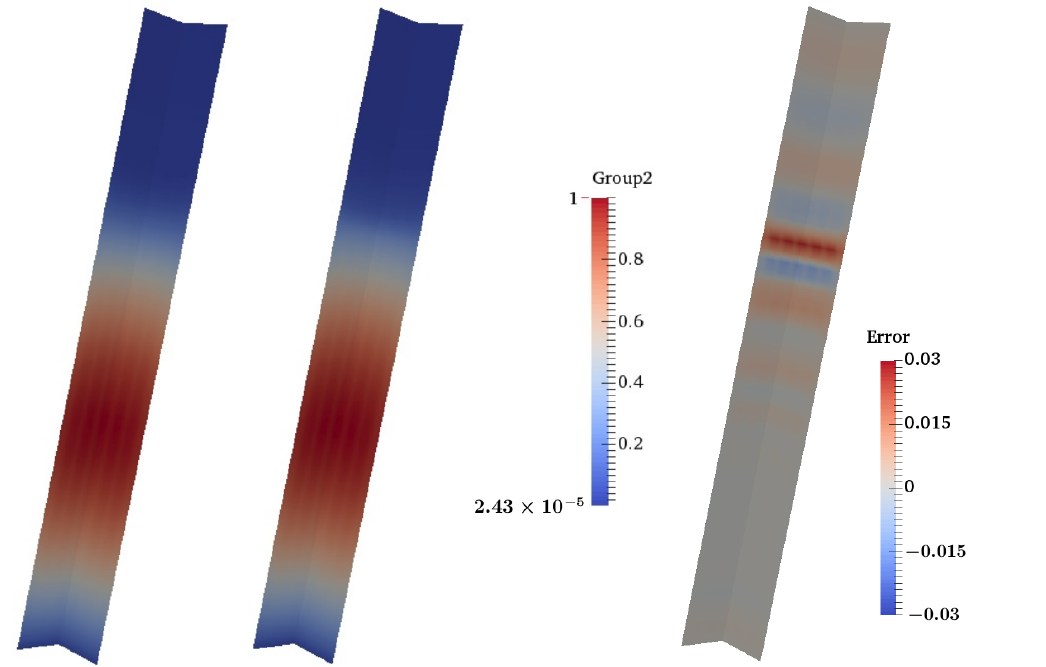
Figure 7. Comparison of the scalar flux (group 2) from the reduced-order model based on GPOD (left) and the high-fidelity model (centre) with the base of the control-rod at a height of 205cm and temperature of 291°C. The pointwise error for these group 2 solutions is shown on the